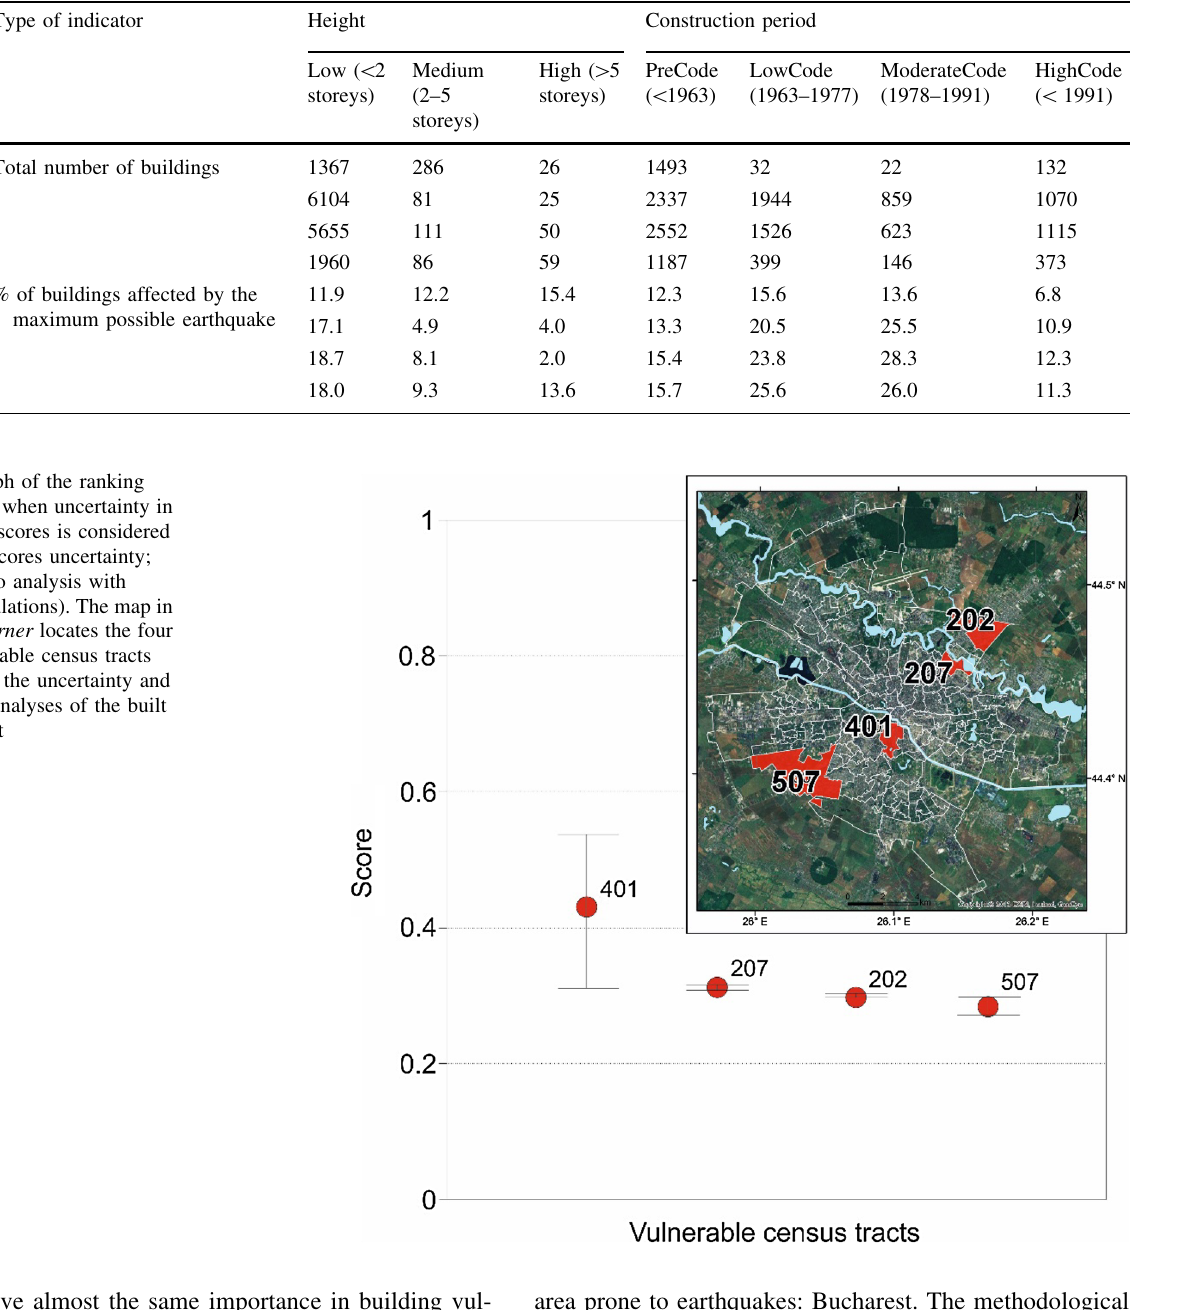
Table 6 Characteristics of the four census tracts selected for uncertainty analysis, in terms of number of buildings and loss estimation results for the maximum earthquake scenario, according to different height classes and construction periods (defined according to SeisDaRo classification) Census tract ID